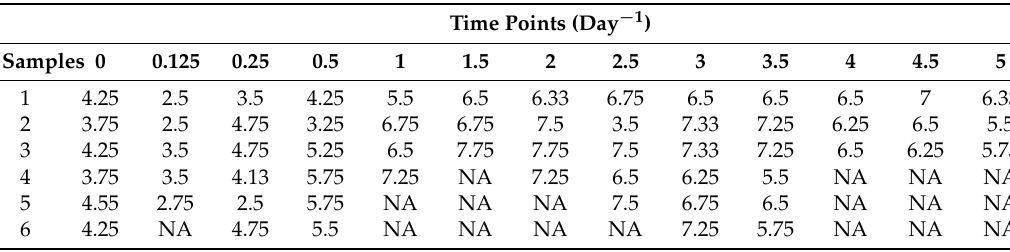
Table 1. Real experimental data from 0 to 5